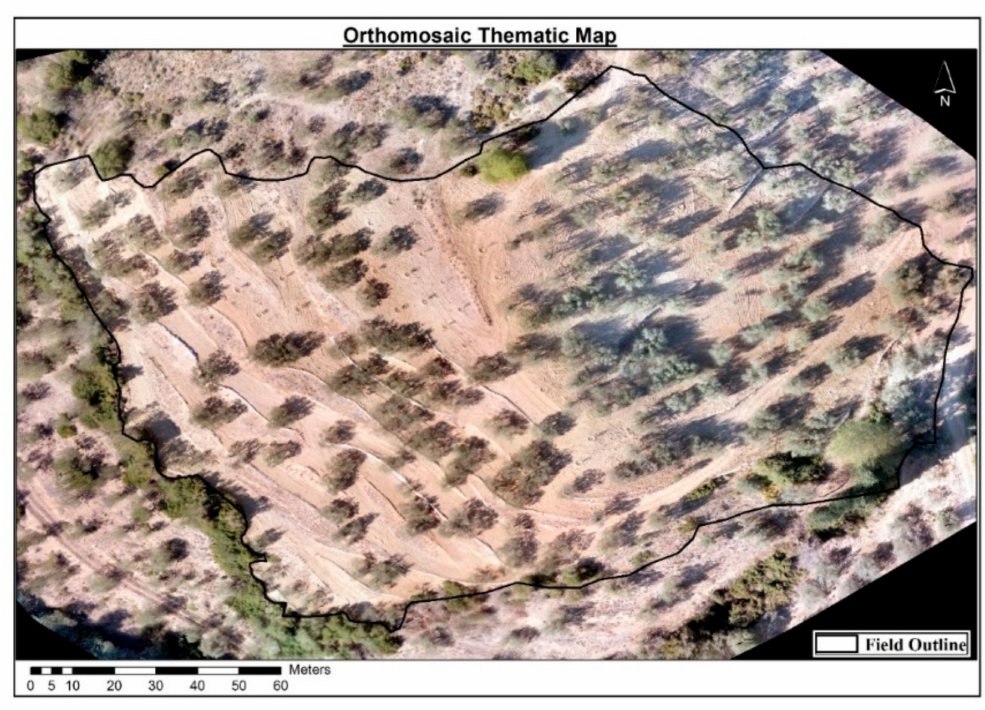
Figure 4. Orthomosaic of the study